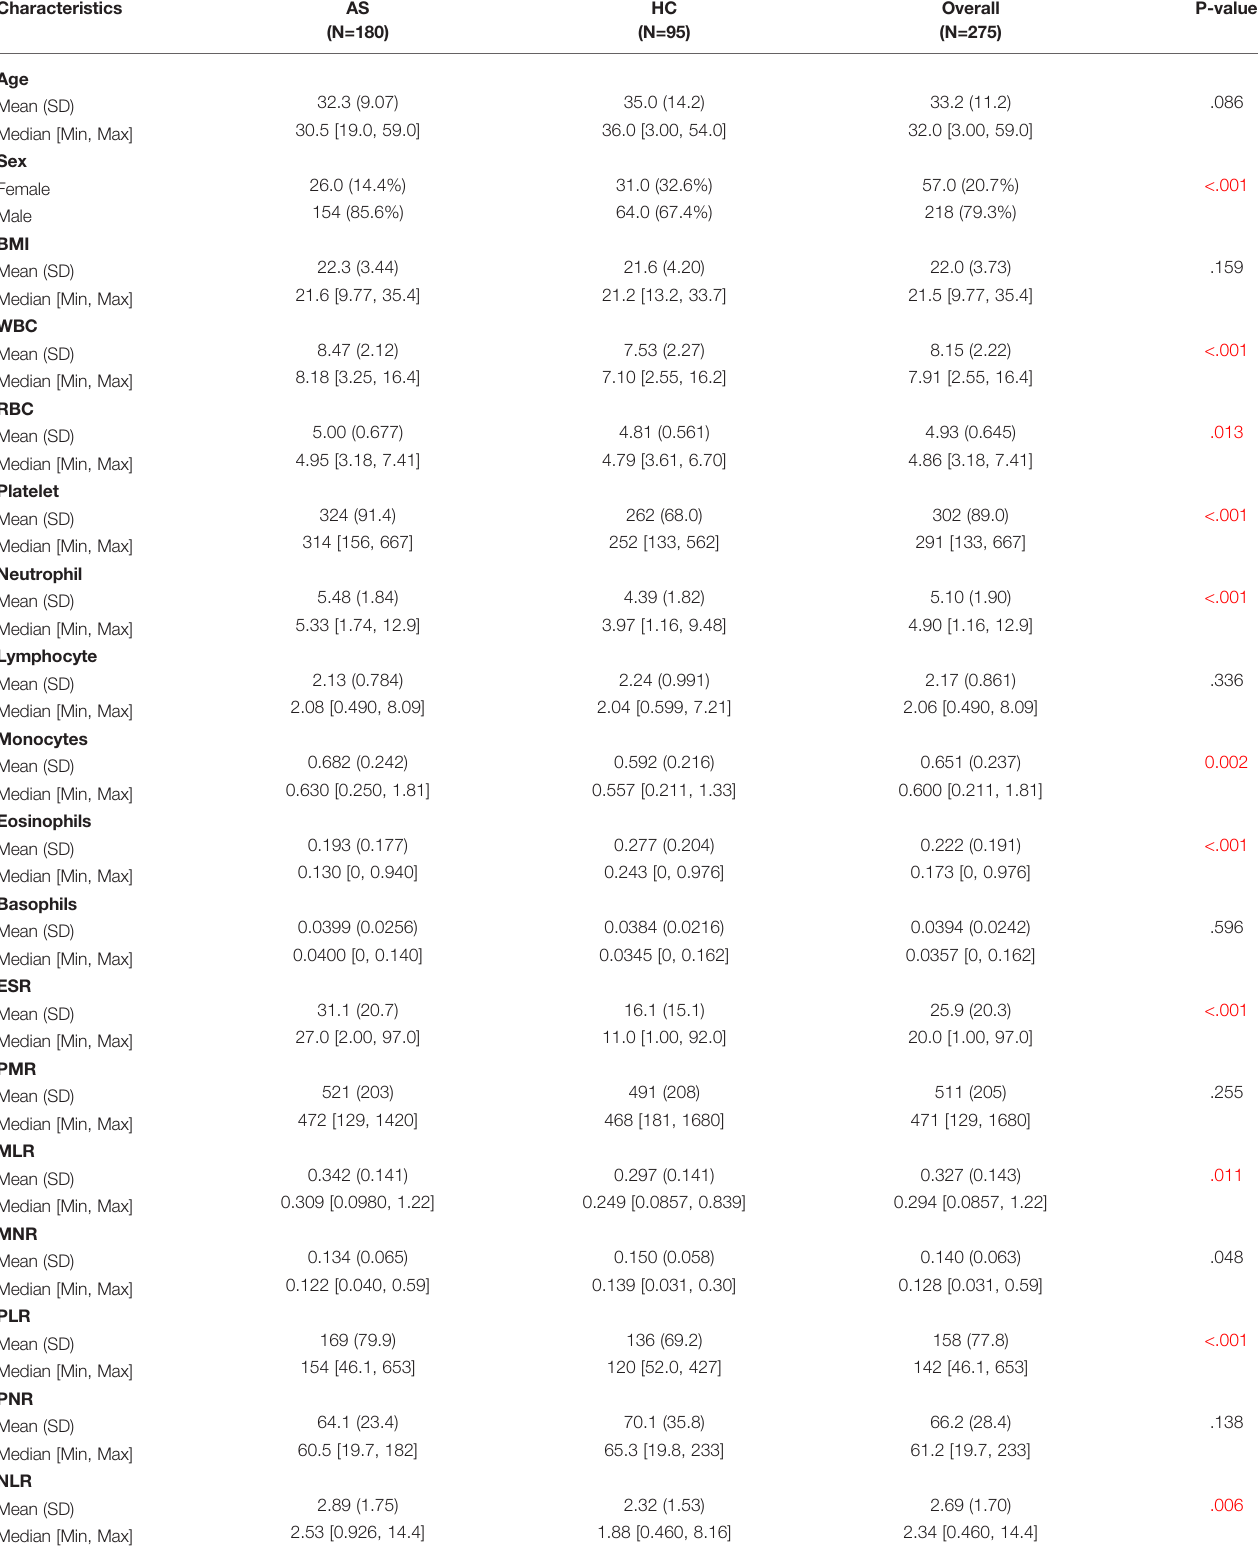
TABLE 1 | Baseline characteristics between AS patients and healthy control.